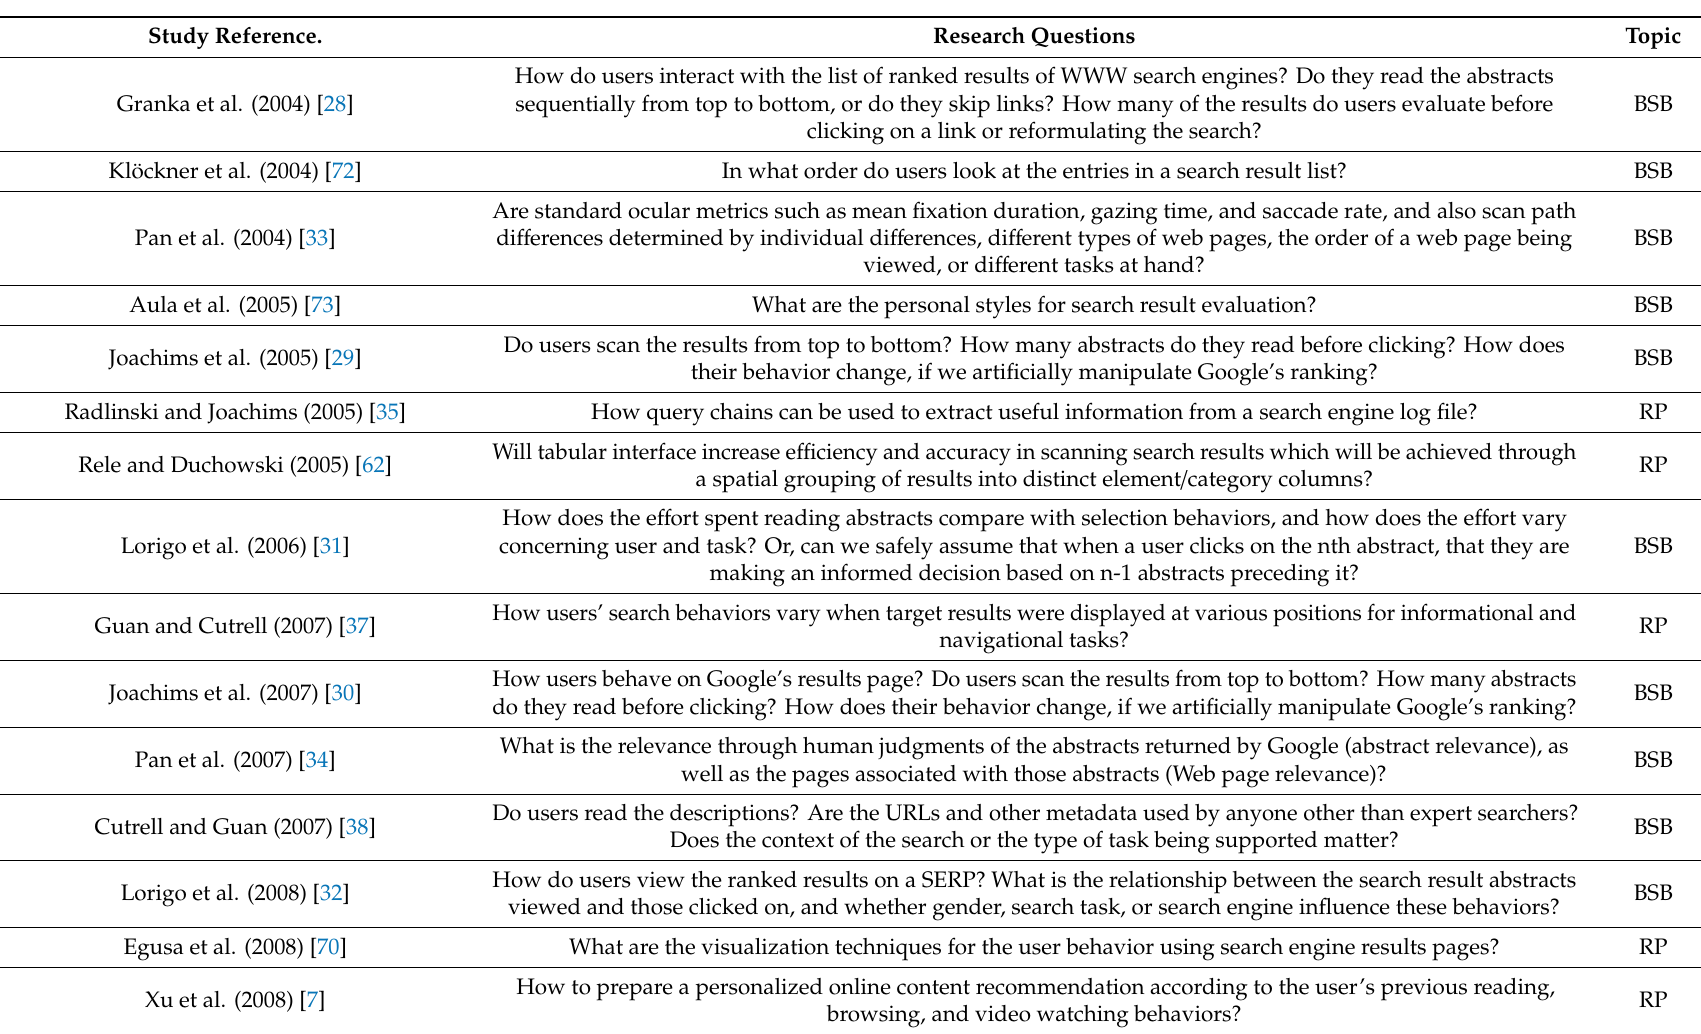
Table 2. Research questions in the reviewed eye-tracking